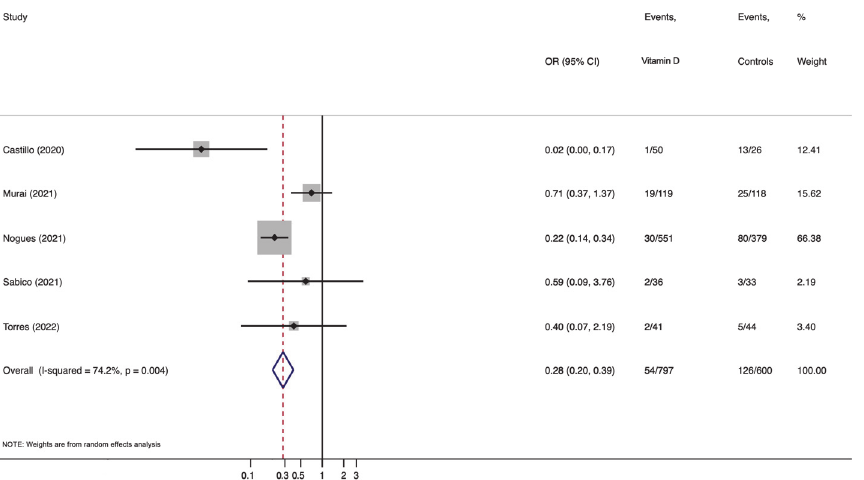
Figure 2. Forest plot of the association of protective effect of vitamin D supplementation with intensive care unit admission in patients hospitalized with COVID-19. CI, confidence interval; OR, odds ratio [26,32,36–38].